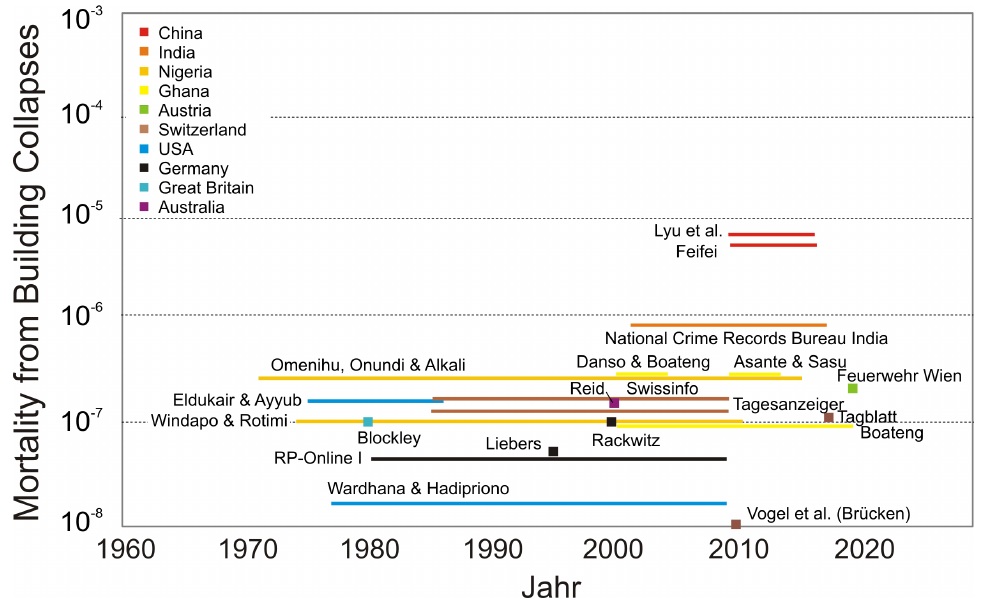
Figure 2. Mortality due to building collapses based on [13]. The individual references are given in [13].